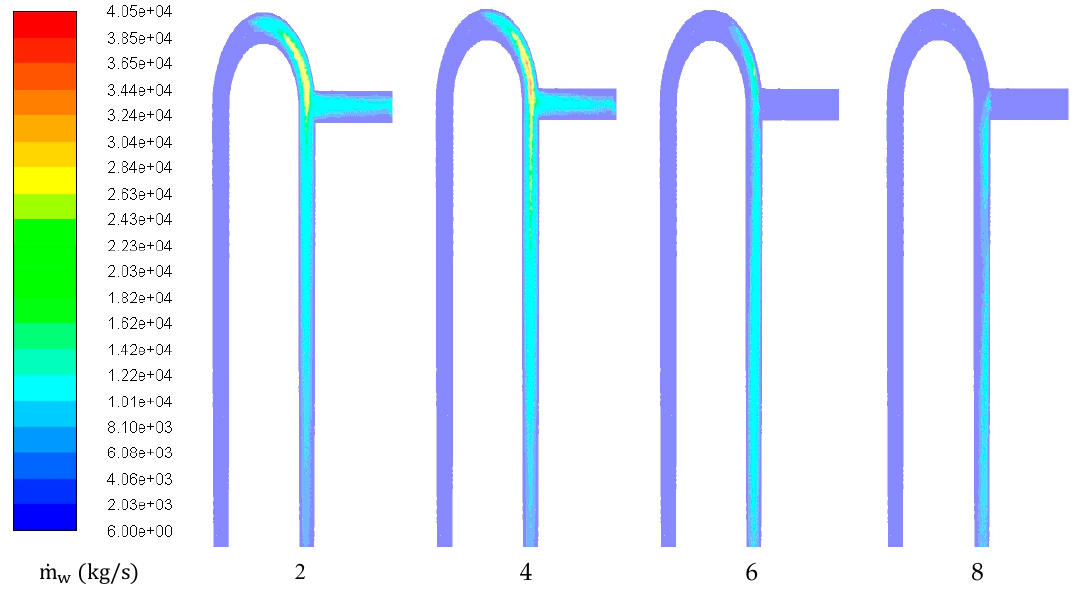
Figure 26. Turbulent Reynolds number contours at di ff erent flow ratios and X w = 662.96, α m = 0.7 and X v = 0.5.